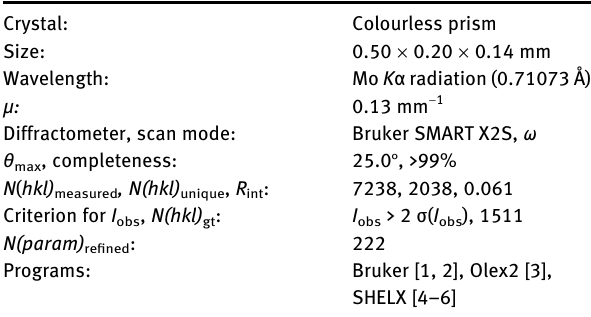
Table  : Data collection and